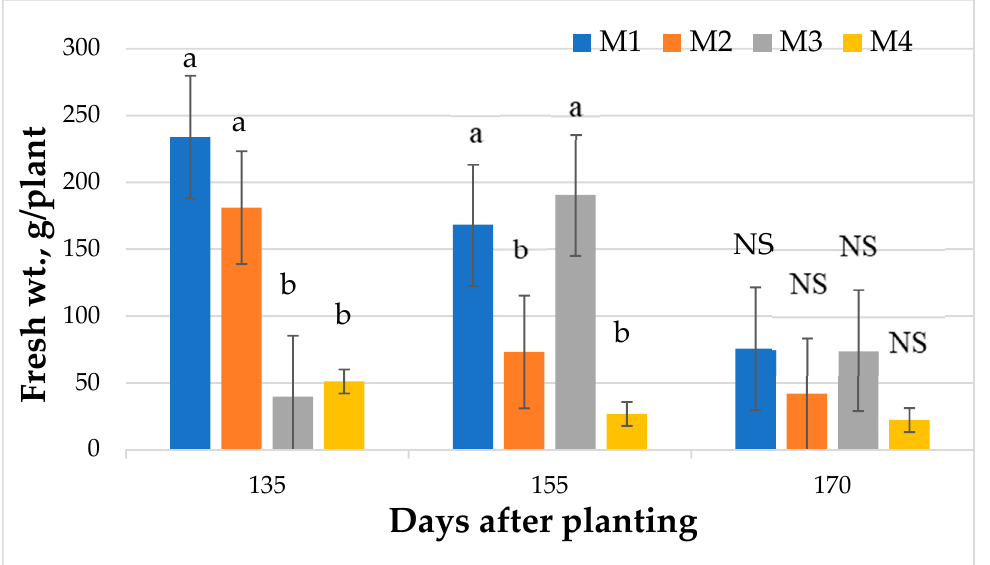
Figure 1. Changes with time in leaf fresh biomass of four mountain mint varieties grown in North Alabama, USA. Bars with same letter are not significantly different at p ≤ 0.05. NS = not significant.